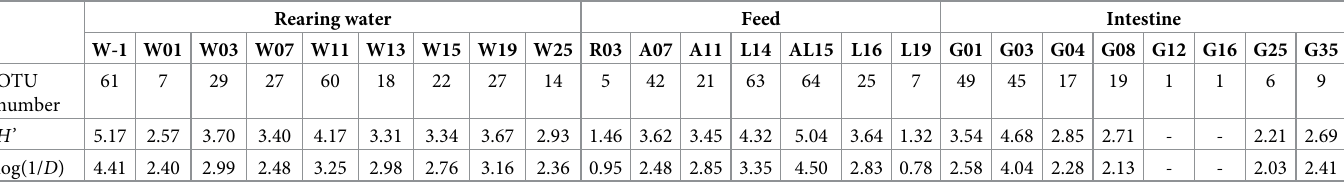
however, no PCR products were obtained from some intestinal samples (S1 Table). The num- ber of OTUs in the rearing water sample tended to be smaller before the beginning of feeding, and those of feed samples varied, even though the feed type was the same. The OTU numbers of intestinal samples decreased with the progression of larval growth (Pearson’s correlation coefficient r = − 0.498, n = 27, p < 0.01), unlike those of seawater ( r = 0.394, n = 31, p < 0.05) (S2 Fig). Simpson and Shannon-Wiener indices of rearing water sample ranged from 1.42 to 4.47 and 1.88 to 5.17, respectively, and those of feed samples ranged from 0.27 to 4.50 and 0.46 to 5.24, respectively. In intestinal samples, Simpson and Shannon-Wiener indices ranged from 0.08 to 4.04 and 0.23 to 4.68, respectively. No correlation of the indices with the progression of larval growth was observed for all samples of rearing water, feed, or intestine.